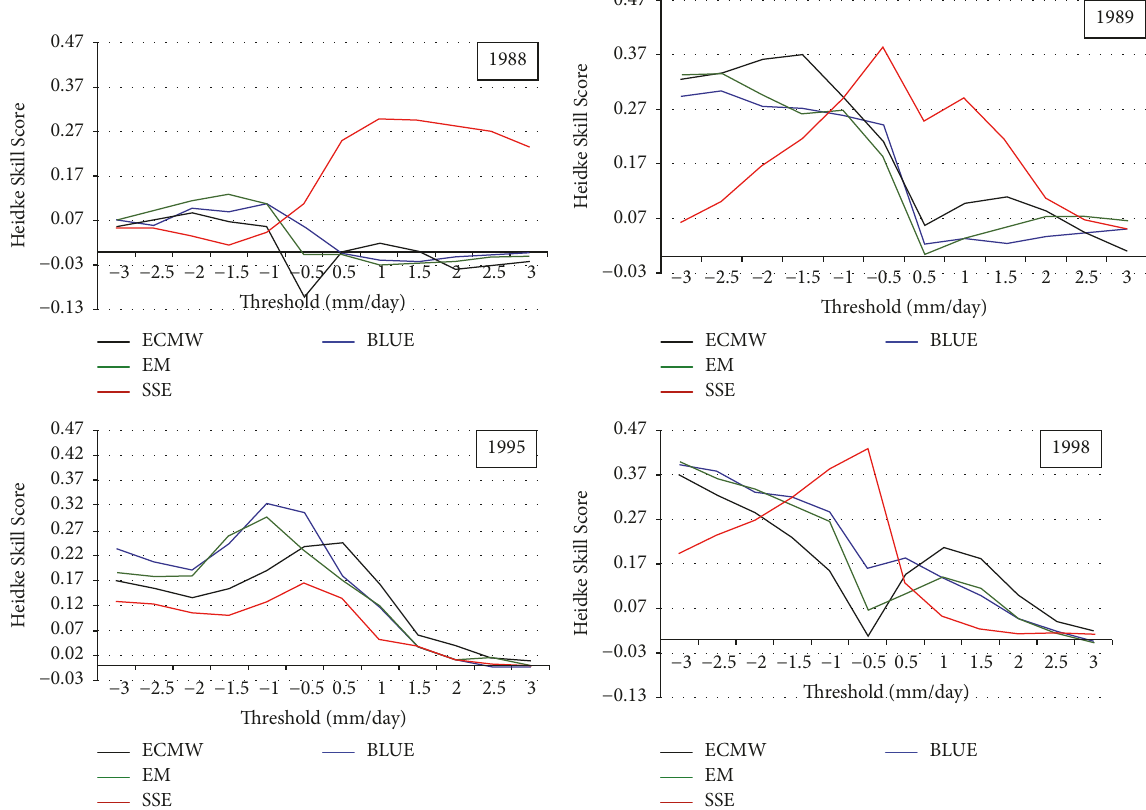
Figure 5: Heidke Skill Score plots for ECMWF, EM, superensemble scheme, and BLUE for JJAS seasonal rainfall anomaly predictions for many years over Indian